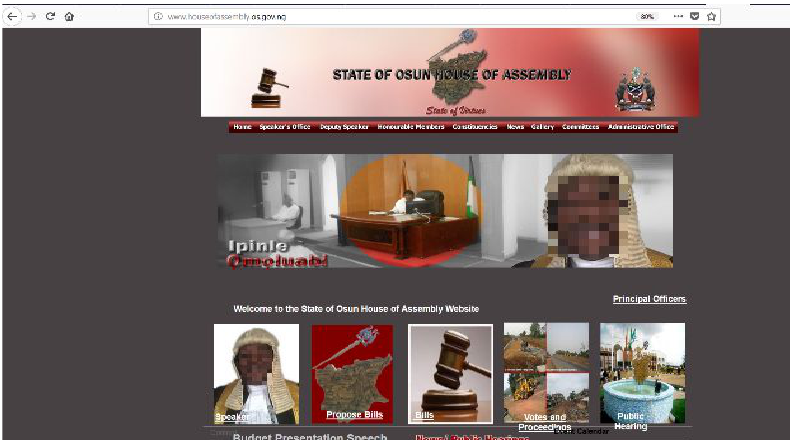
Figure 6: Osun State House of Assembly Official Website